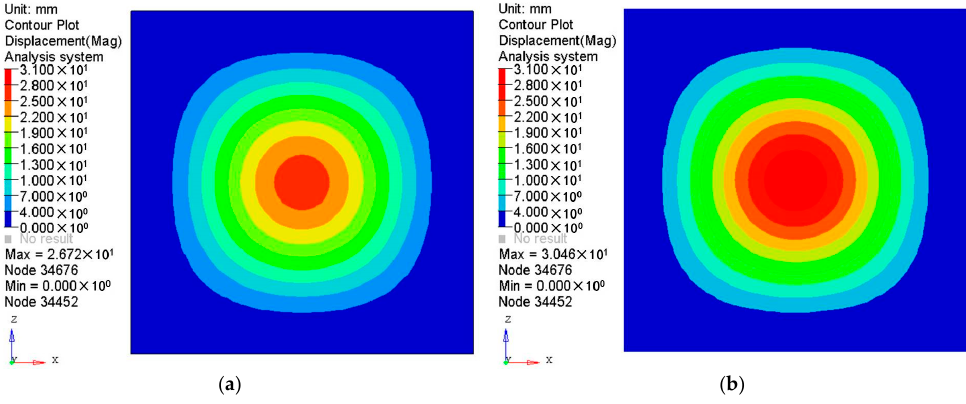
Figure 3. Displacements of ( a ) isotropic and ( b ) orthotropic plates under pressure of 0.1 MPa.